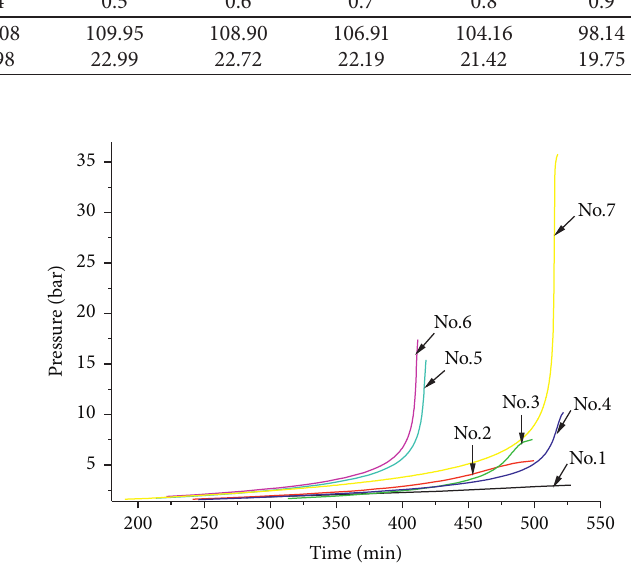
Figure 5: P - t of exothermic section for sample